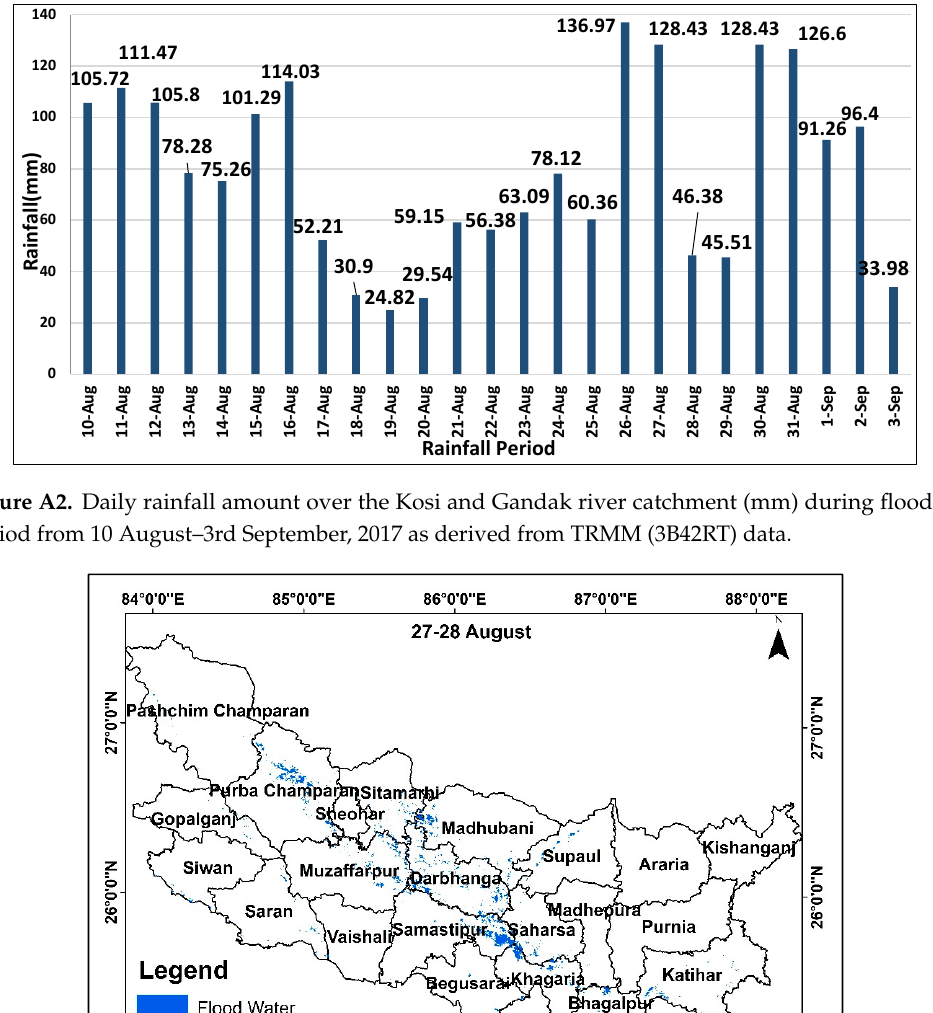
Figure A3. Flood inundation extent as derived from MODIS Flood NRT data during 27–28th & 29– 30th Aug, 2017.